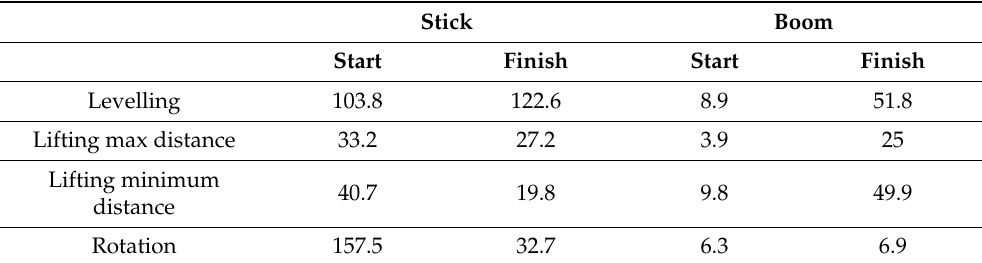
Table 5. Start and end stresses [MPa] for the stick and